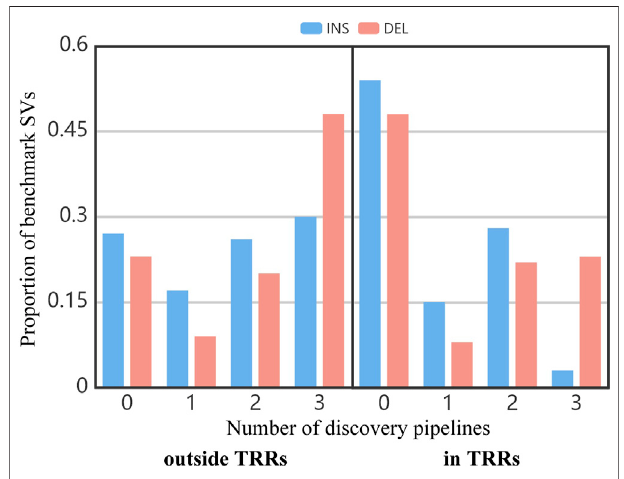
FIGURE 3 | The proportion of benchmark SVs concurrently detected by different number of